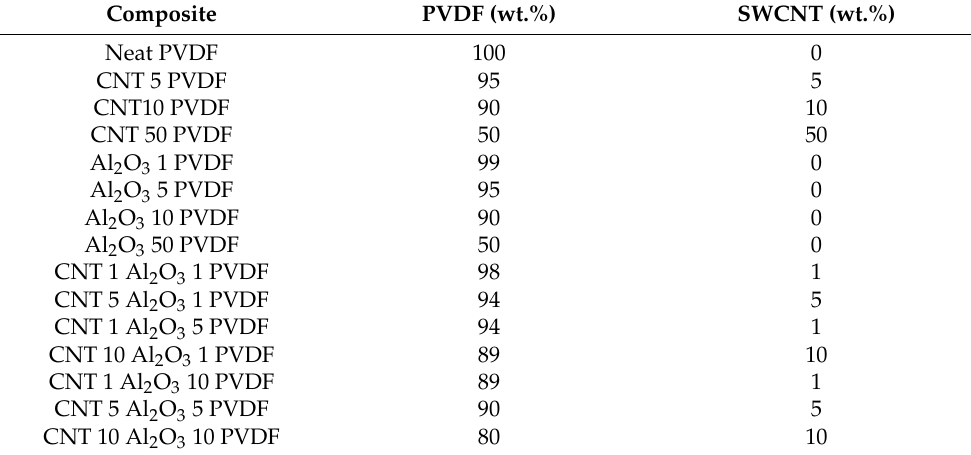
Table 1. Composition of the nanocomposites.